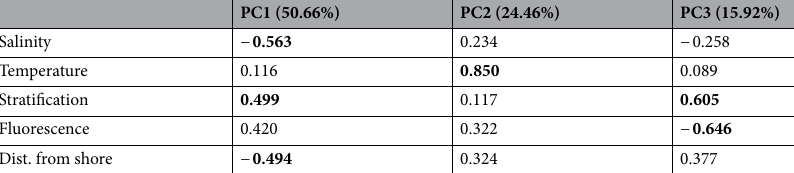
Table 2. Coefficients of the first three axis from the principal component analysis. Cumulative proportion of variance explained with the first three axis equals 90%. Bolded values represent absolute values exceeding the predicted sum of squares, assuming all equal parameter contribution